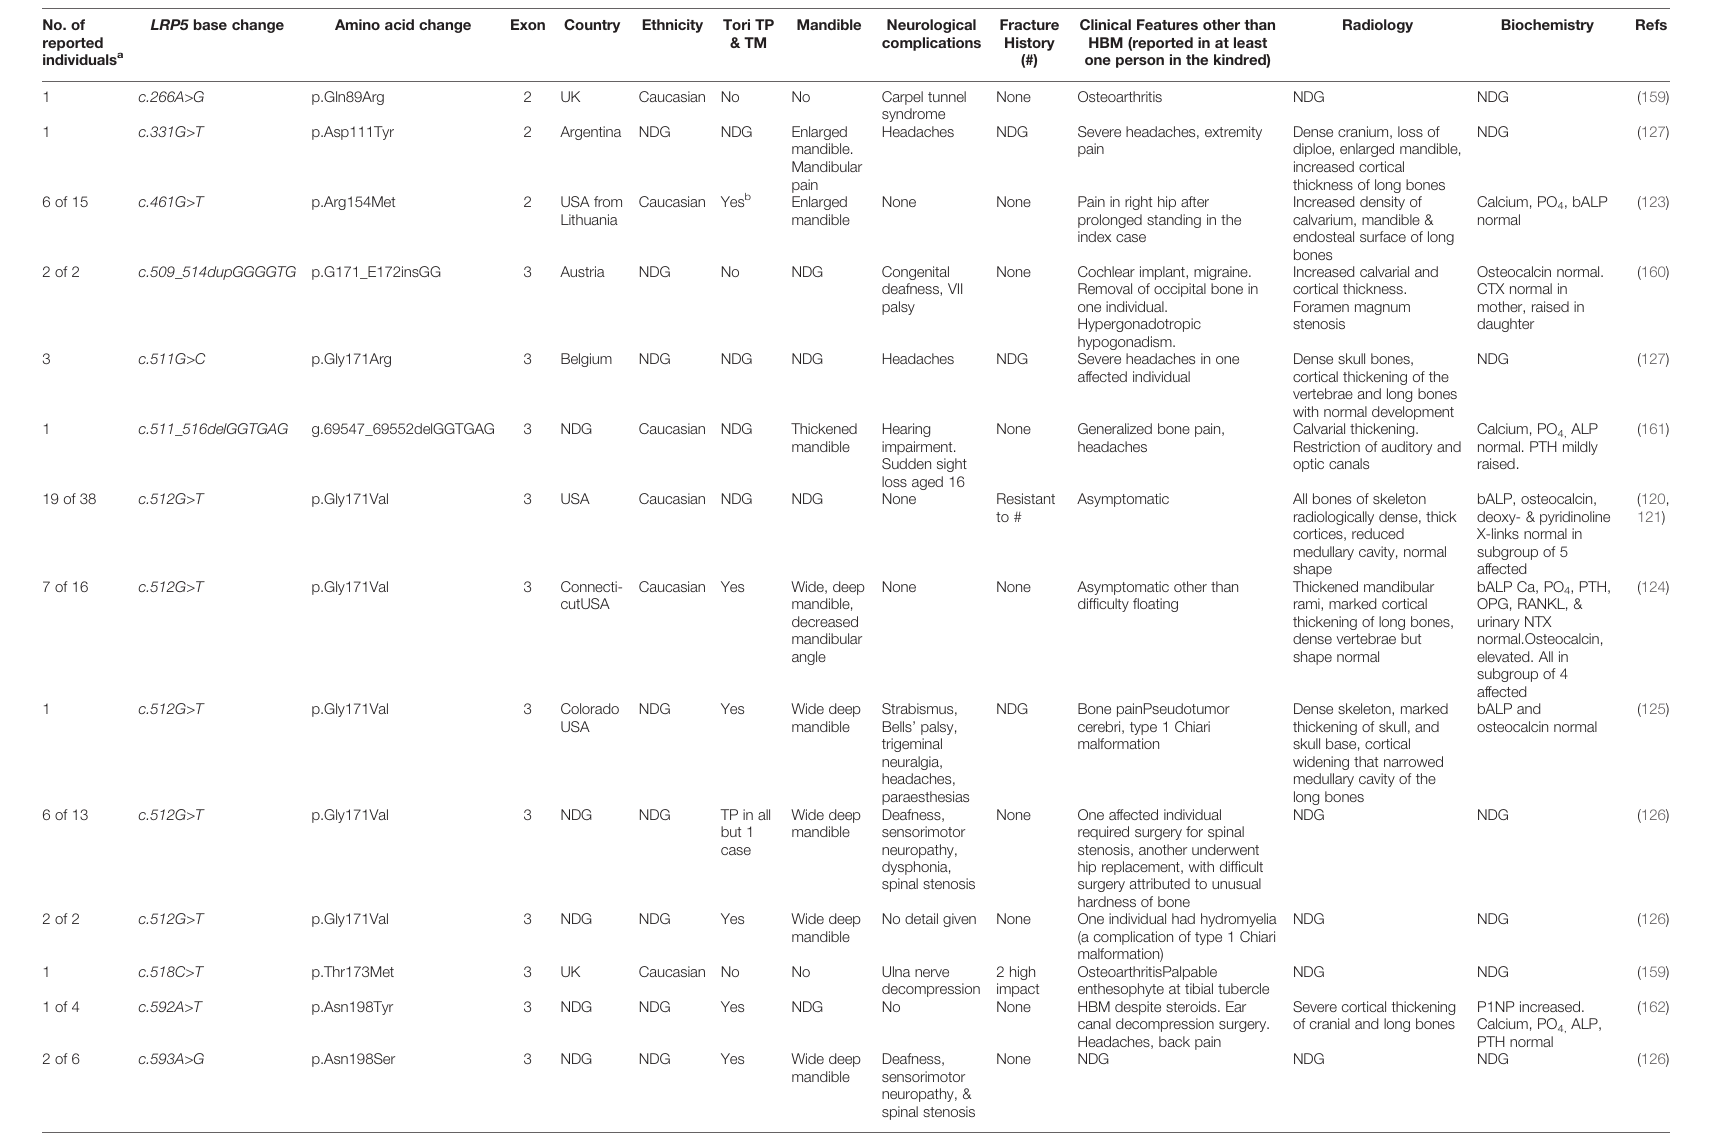
TABLE 3 | LRP5 mutations and associated clinical and radiological characteristics reported to date. No. of